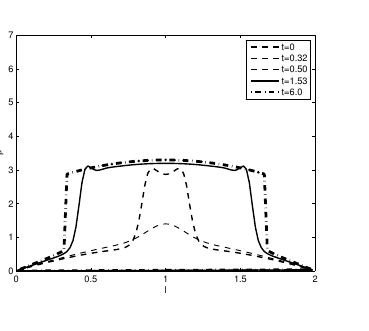
Figure 7. Droplet dynamics at ωτ = 0 ⇒ 5, t f =